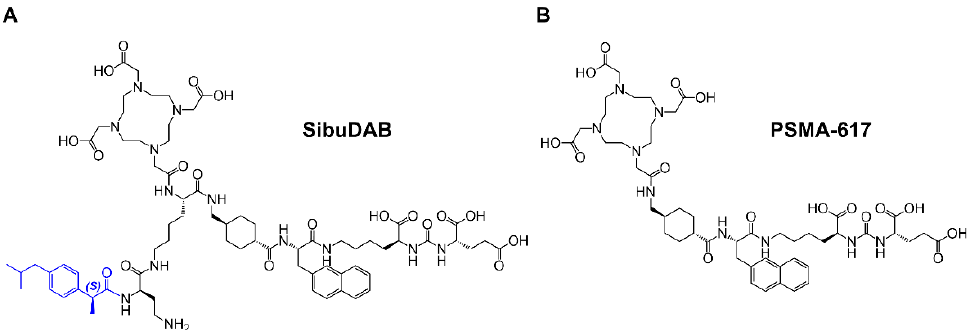
Figure 1. Chemical structures of the PSMA ligands. ( A ) SibuDAB, referring to a PSMA ligand equipped with the ( S )-ibuprofen (blue) as an albumin-binding entity conjugated via diaminobutyric acid (DAB) and a lysine residue [17] ; ( B ) PSMA-617 as a reference compound [18] .